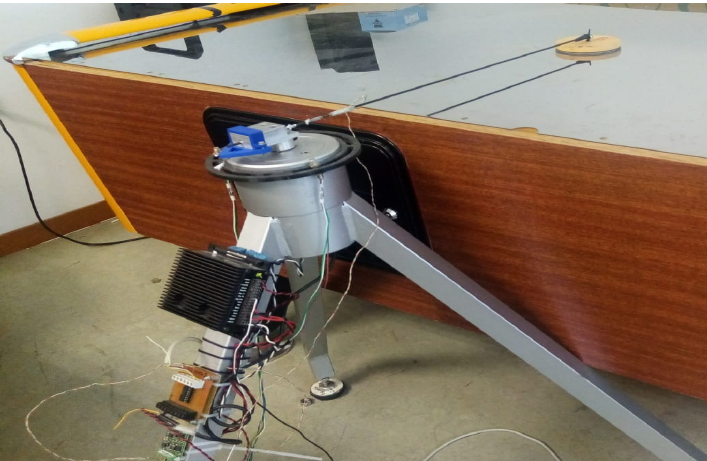
Figure 5. Air table flexible robot